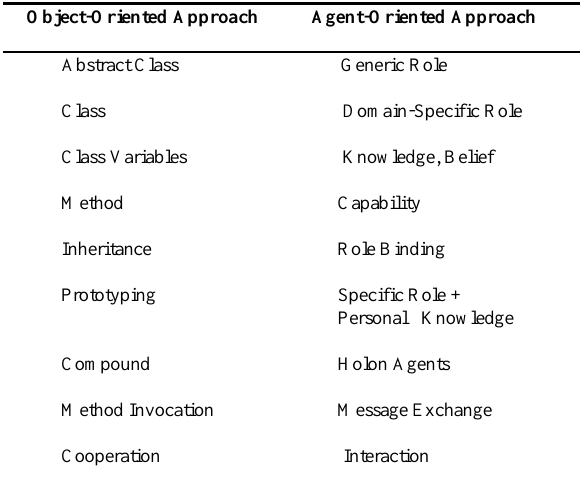
Table1. Mapping of object-oriented and agent oriented approaches